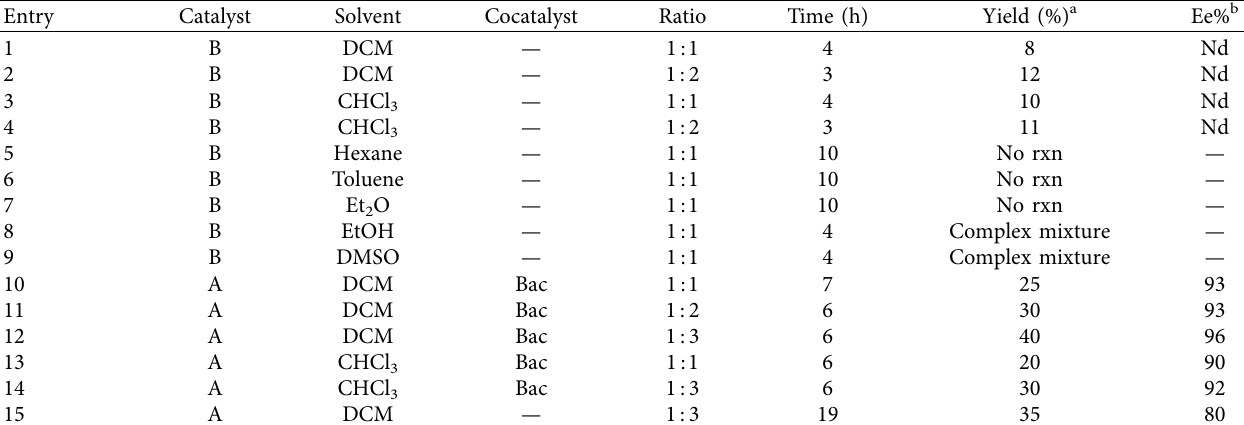
Table 1: Influence of solvent, stoichiometric ratio, catalyst, and cocatalyst in the 1a to 2a Michael addition. Entry